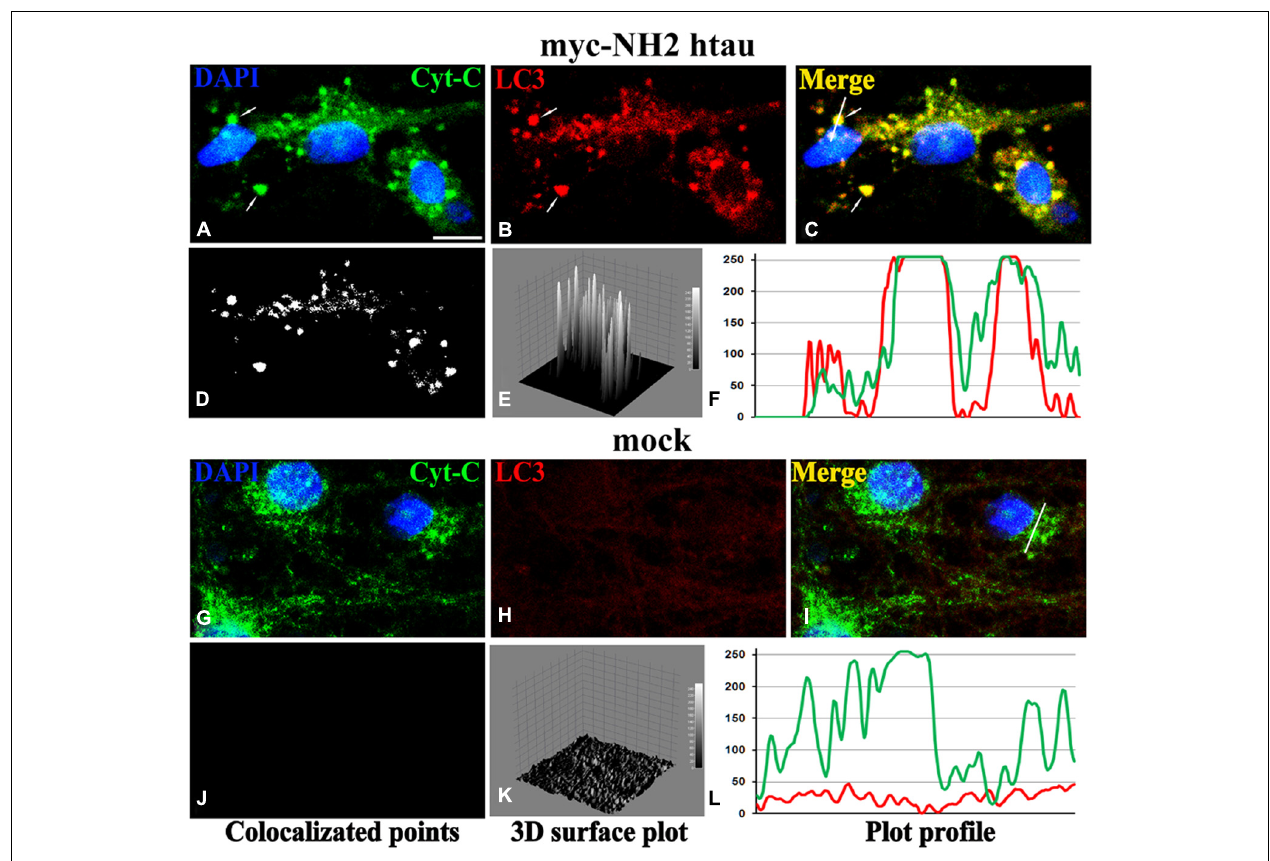
FIGURE 2 | Confocal microscopy and image analysis of double immunofluorescence for cyt C (a mitochondrial marker; green channel) and LC3 (for visualization of autophagosomes; red channel), carried out on primary mature hippocampal cultures (15 DIV) at 12 h post-infection (MOI 50) with mock- and myc-NH 2 26-230 human tau vectors. Nuclei were stained with DAPI (blue channel). (A–C) Numerous labeled LC3 stained vesicles intensely posi- tive (colocalized) for cyt C were observed in myc-NH2htau neurons.